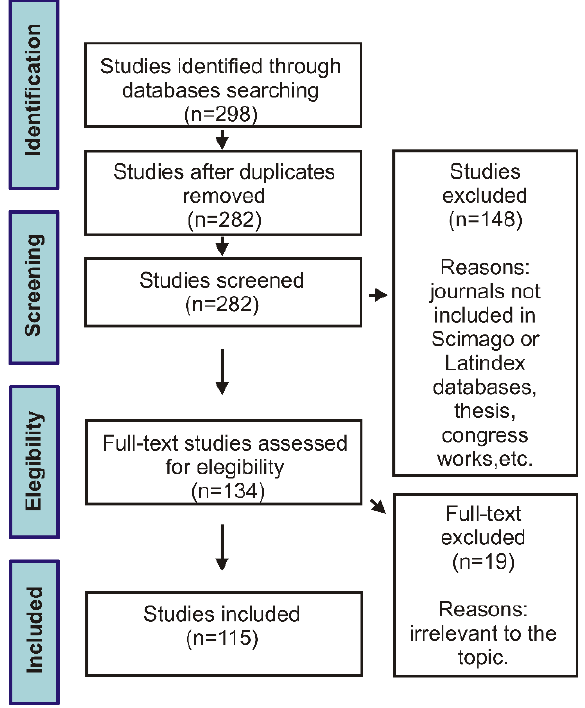
Figure 1. Literature screening procedure (flow chart).